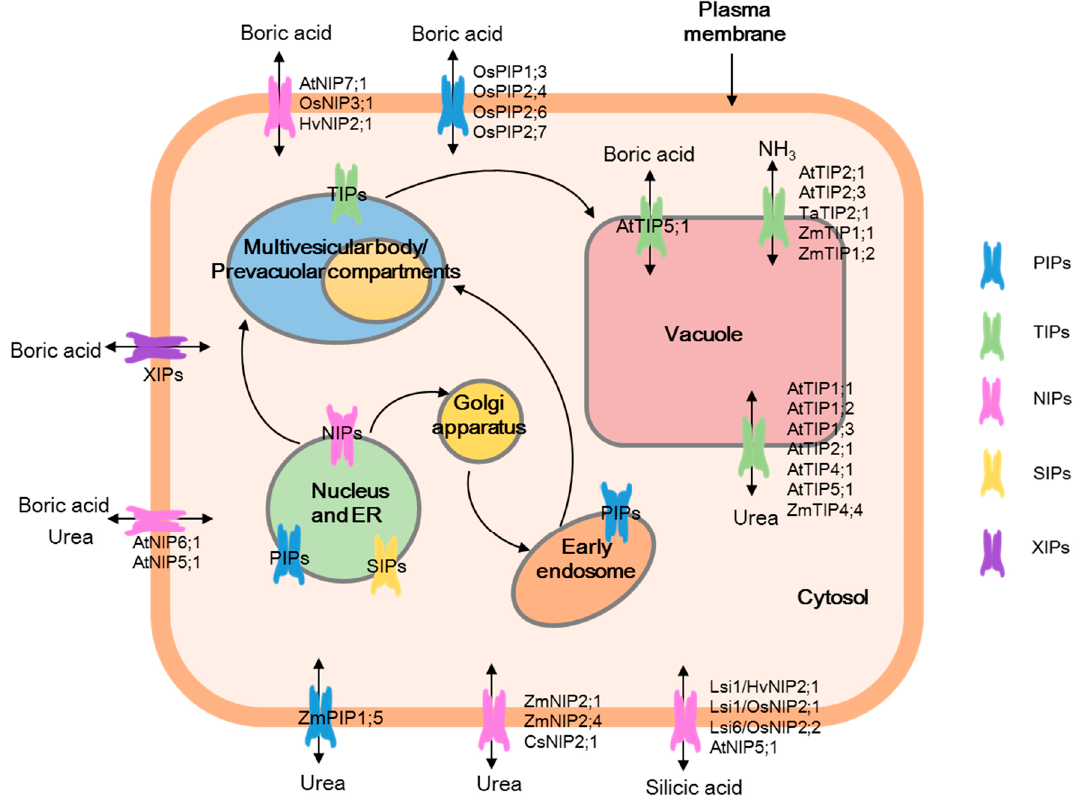
Figure 2. The multiple cellular functions of plant aquaporins in mineral nutrition. The figure illustrates the variety of transporter functions of aquaporins in various subcellular compartments. The different subclasses of aquaporins are identified in different colours. The plasma membrane intrinsic proteins (PIPs) might be involved in the internal re-distribution of mineral nutrients by transporting them from the endoplasmic reticulum (ER) to the plasma membrane via the Golgi apparatus. Moreover, PIPs also undergo repeated cycles of endocytosis and recycling through the early endosome to the multivesicular body/prevacuolar compartments before eventually being targeted to the vacuole. PIPs primarily facilitated urea and boric acid transport, while tonoplast intrinsic proteins (TIPs) are principally involved in urea, NH 3 , and boric acid transport, and nodulin 26-like intrinsic proteins (NIPs) are involved in urea, boric acid, and silicic acid transport.